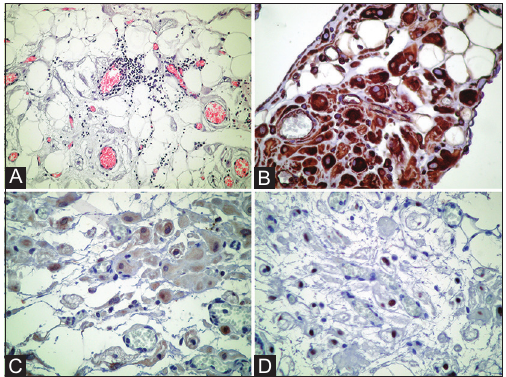
FIGURE 1. (A) Decidual deposits infiltrated with mature fatty cells, inflammatory cells, and hyperemic blood vessels, hemalaun & eosin, 40x. (B) Immunohistochemical staining for vimentin in decidual cell cytoplasm, vimentin, 40x. (C) Immunohistochemical staining for S-100, S-100, 40x. (D) Immunohistochemical staining for progesterone, progesterone,